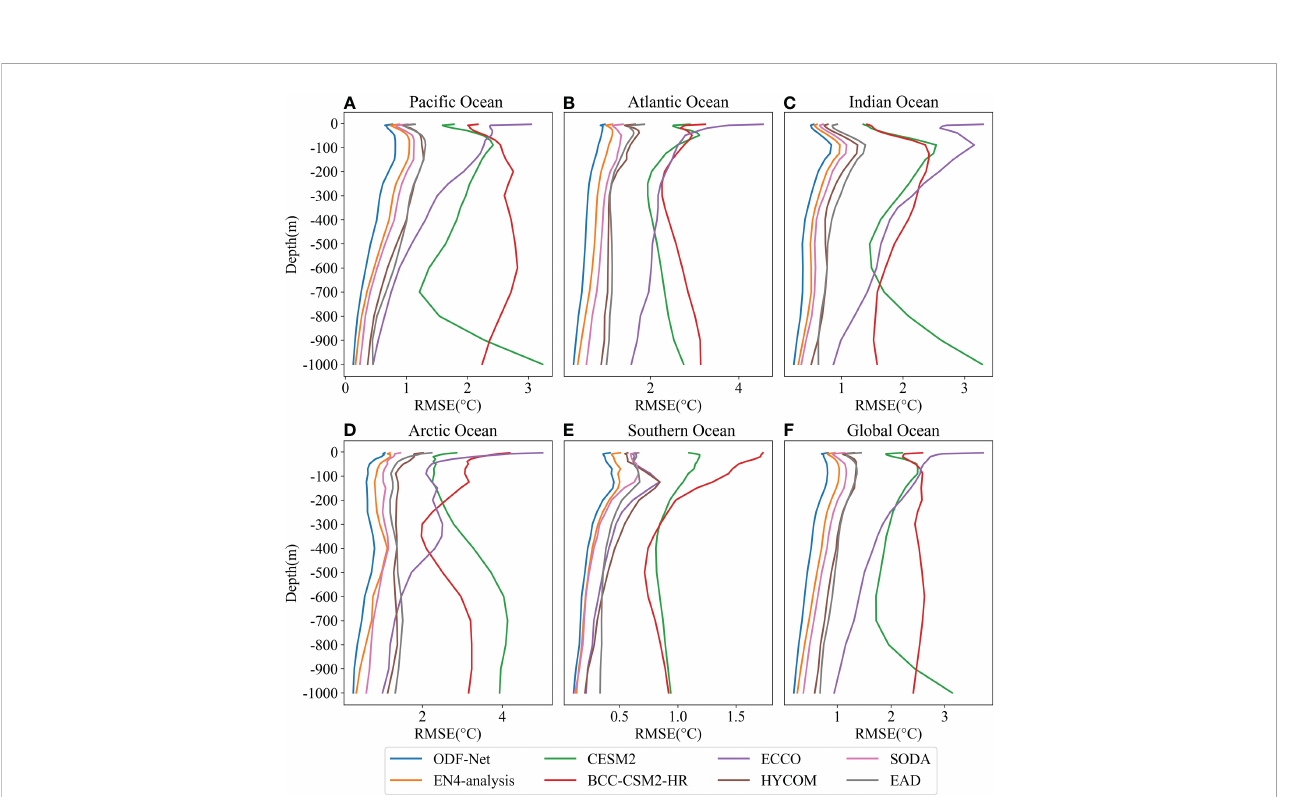
FIGURE 5 Vertical distribution of time-averaged RMSEs in (A) Paci fi c Ocean, (B) Atlantic Ocean, (C) Indian Ocean, (D) Arctic Ocean, (E) Southern Ocean, and (F) Global Ocean.